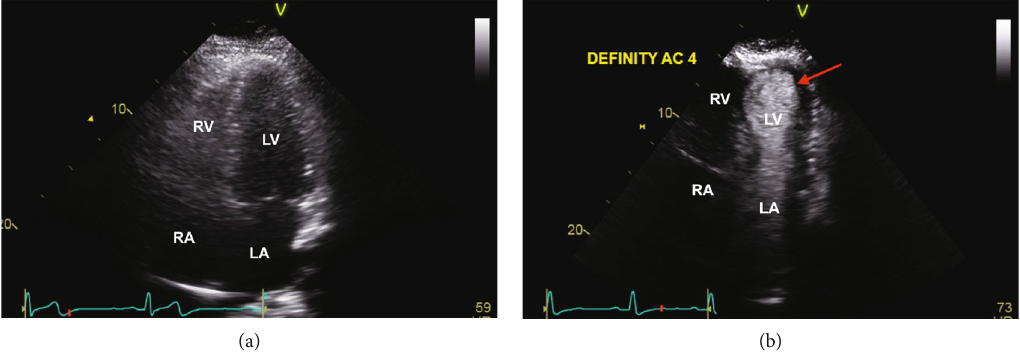
Figure 3: Transthoracic echocardiogram, apical 4-chamber view, demonstrates (a) normal LV contractility three years prior and (b) contrasted study with LV dysfunction with apical dyskinesia (red arrow), consistent with takotsubo